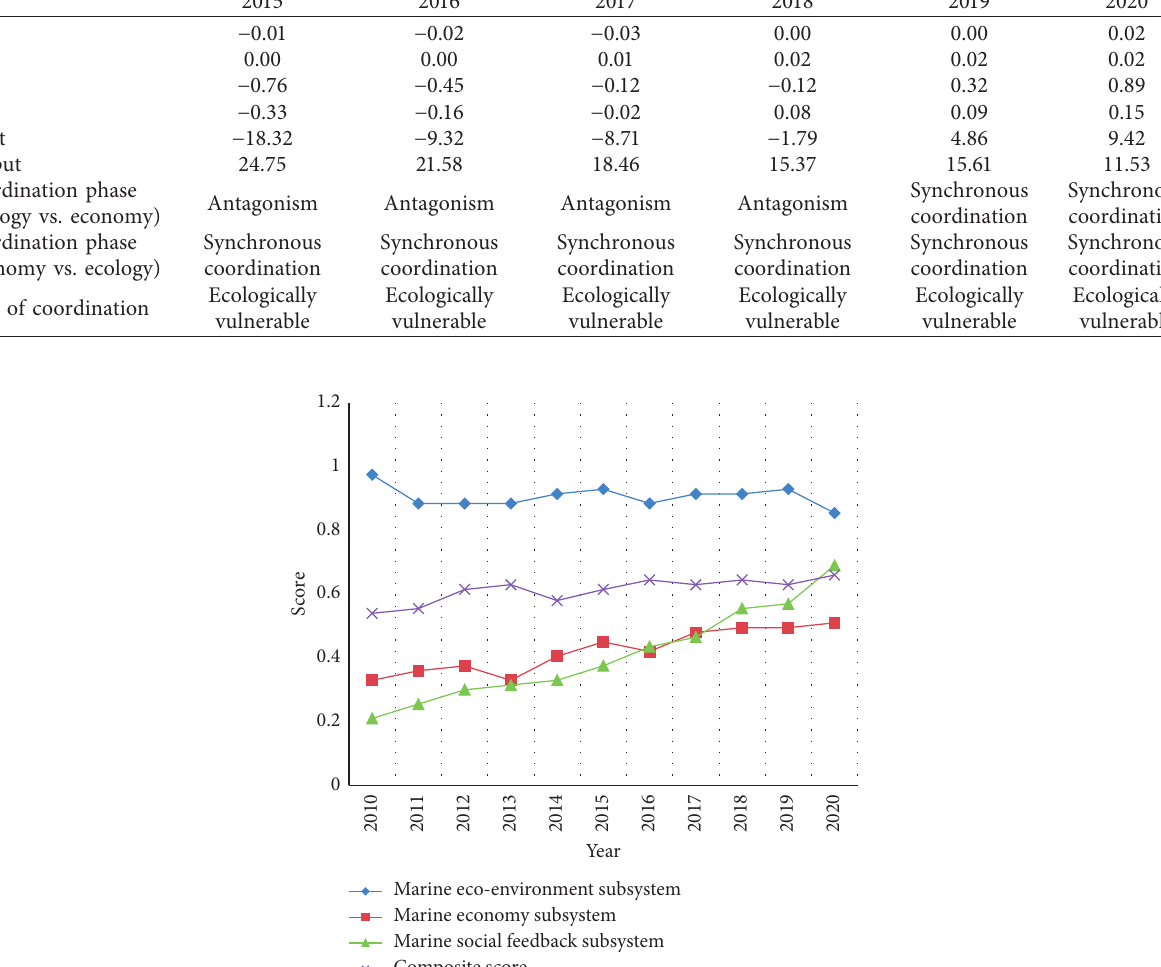
Figure 7: Composite score of subsystem development.